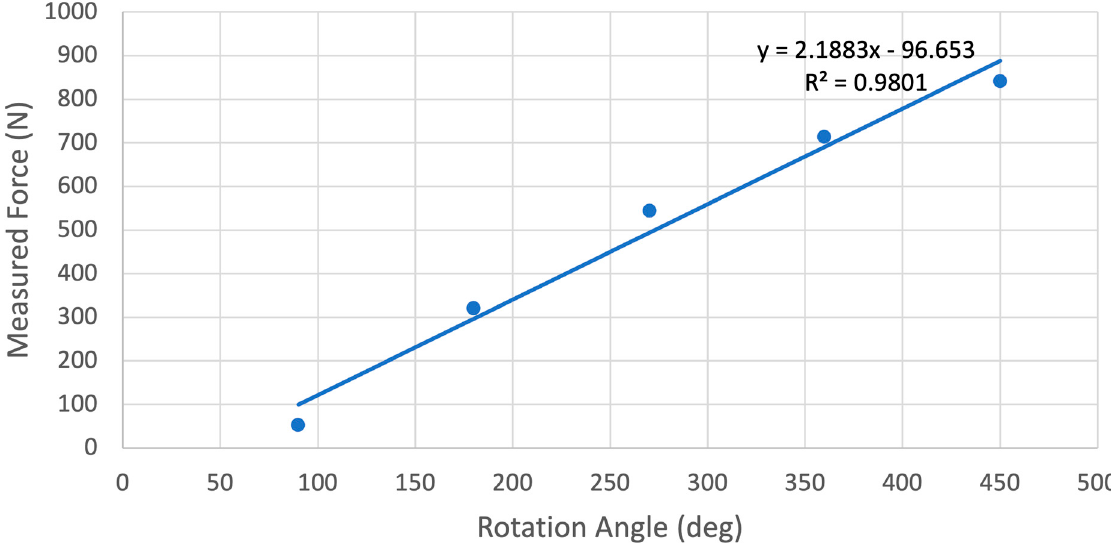
Figure 8. Average force exerted by roller screw onto load cell per 90-degree rotation.